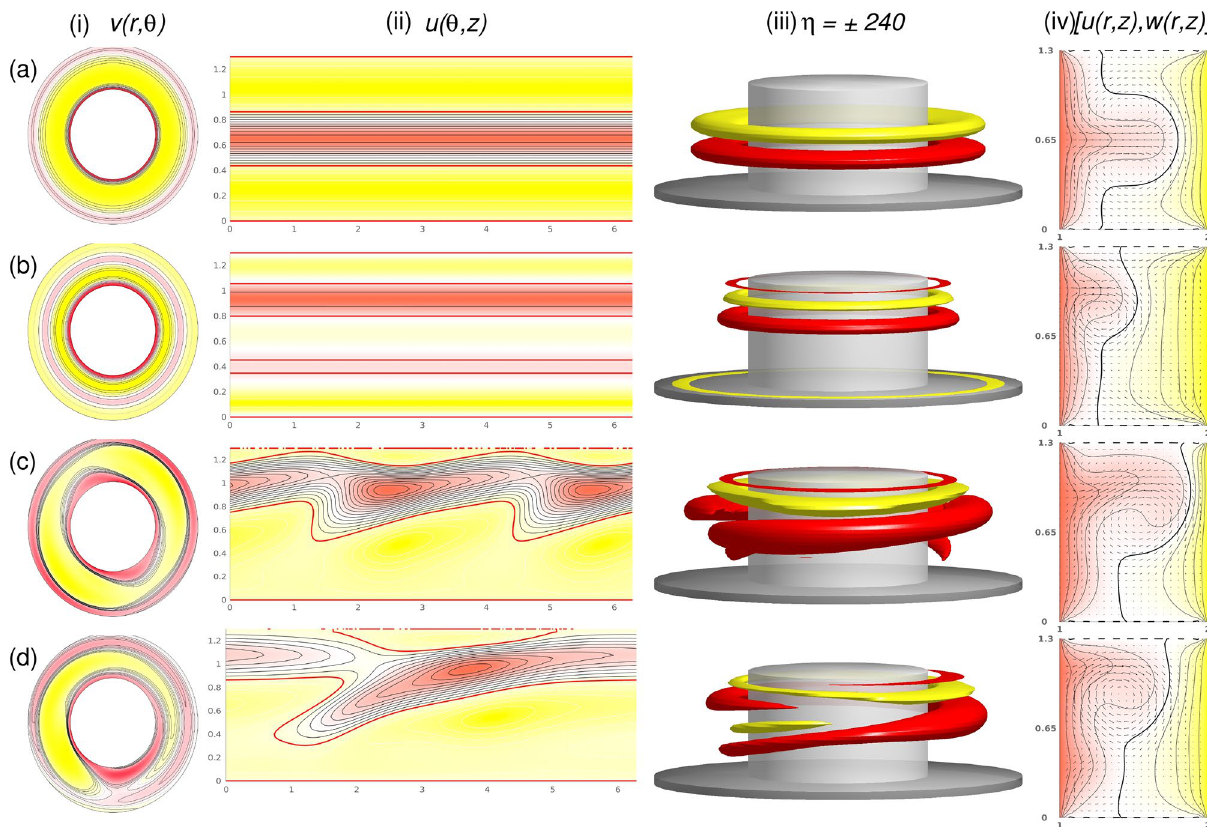
1 ; (b) T2 at α 4.1 ; (c) RW 2 Figure 3. Stationary and rotating flow structures. Shown are (a) N2 at α = = − 8.2 ; and (d) MRW 1,2 at α 0 (see SM Fig. 1 for the corresponding spectra of the mode amplitudes). at α = = Shown are ( i ) the azimuthal velocity, v (θ , z ) , at mid-height [red (yellow) color indicates positive (negative) flow, respectively], ( ii ) the radial velocity u (θ , z ) on an unrolled cylindrical surface in the annulus at mid-gap [red (yellow) color indicates out (in) flow, respectively], ( iii ) isosurfaces of η [red (dark gray) and yellow (light gray) colors correspond to positive and negative values, respectively, with zero specified as white] and ( iv ) vector plot 0 ) of the radial and axial velocity components, including color-coded azimuthal velocity [ u ( r , z ), w ( r , z )] (at θ = v (analog visualizations are used in the following to characterize the flow structures in the pair (4-cell) state 31,32,35 (Fig. 3(2)) appears. Other than N2, the T2 solution is not reflection symmetric about mid- 4.11 (cid:31) α (cid:31) 3.87 , T2 is stationary but becomes time-dependent height, indicating a broken Z 2 symmetry. For − − (periodic pulsating) with increasing α above